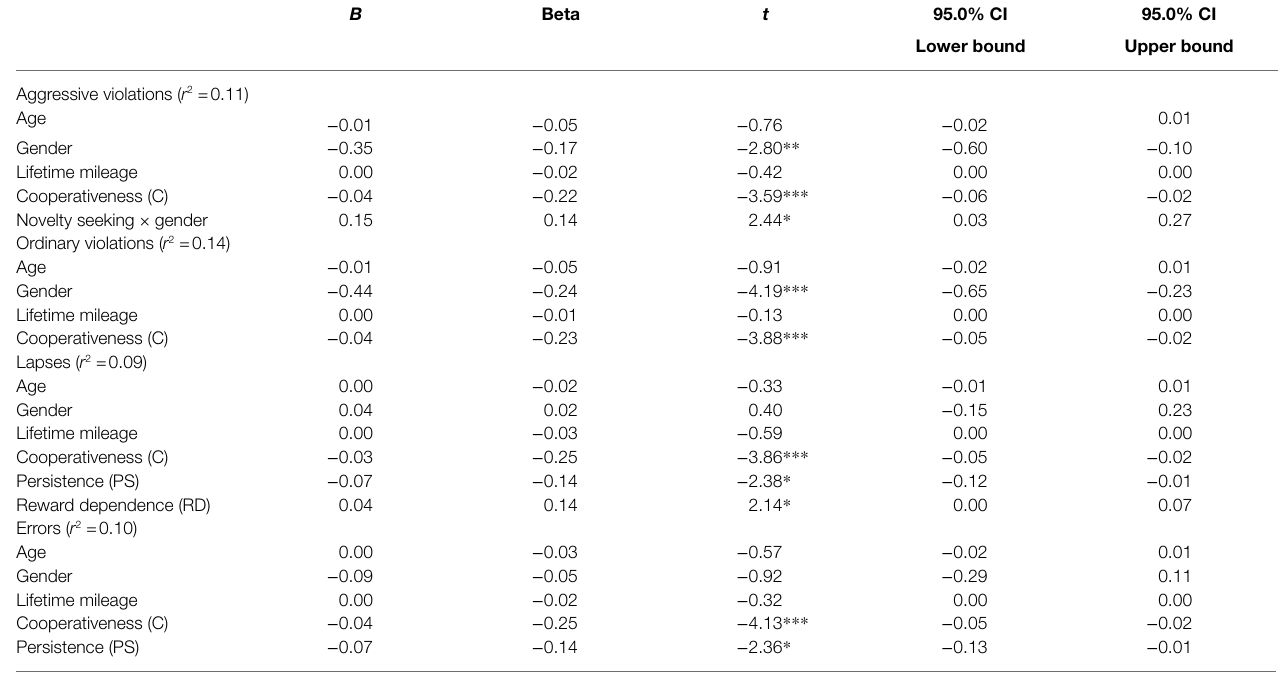
TABLE 3 | Temperament and risky driving: regression analysis results for DBQ variables as the dependent variable. B